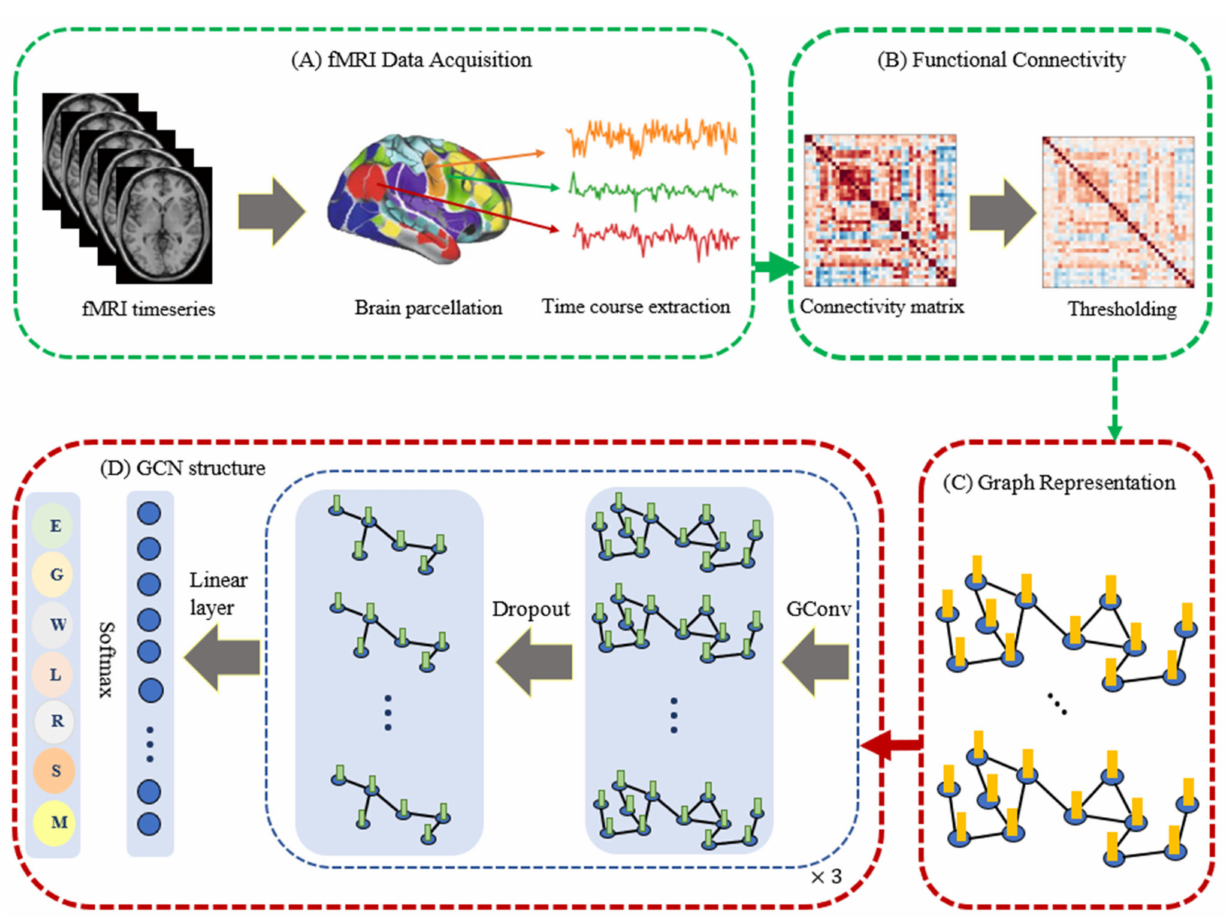
Figure 1. Overview of our Graph Convolutional Network (GCN) model for task fMRI classification. After acquisition of the raw task fMRI data and identification of the brain’s divisions into various parcels, several time courses of each parcel were extracted ( A ) to create the functional connectivity matrix. To reduce the complexity of the graph, a threshold was applied to the connectivity matrix ( B ) and transferred to a graph. The initial representation of each node was extracted by using the FRESH algorithm and node embedding methods ( C ). Finally, the feature vectors were used to perform the classification task with the proposed GCN framework including three Conv layers followed by a dropout layer after each Conv layer ( D